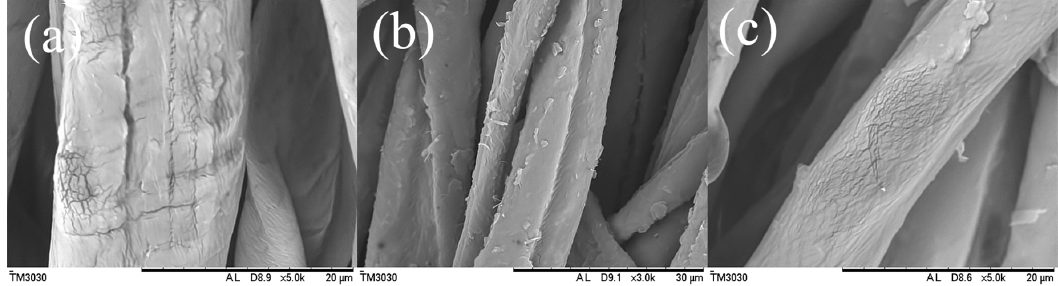
Figure 8. SEM images of the finished fabric after ( a ) 25 abrasions, ( b ) immersion in solution with pH 1, ( c ) immersion in solution with pH 13.